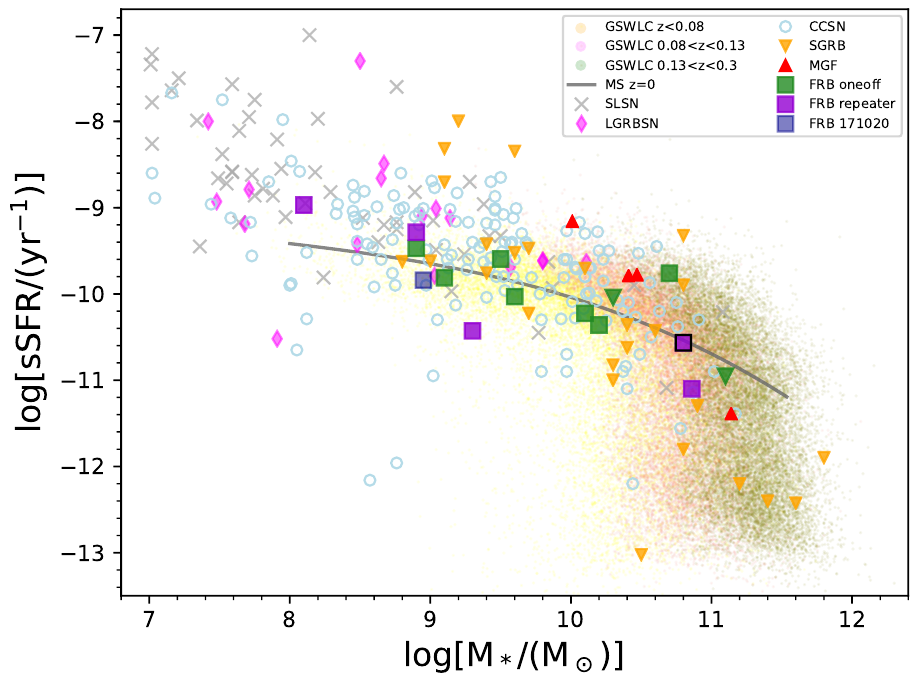
Figure 2. Specific SFR (SFR/M ∗ ) plotted against stellar mass for the FRB hosts and the galaxy pop- ulations of other transients. SFR and stellar mass values to derive the specific SFR are from [37,38] (FRB 20180916B), [93] (FRB 20200120), [78] (FRB 20180924B), [79] (FRB 20190523A). For the two latter FRBs the reported SFR values mark the upper limits (UL). The FRB hosts are indicated by filled squares (green for the one-off, purple for the repeaters) and filled green triangles for the two UL values. The associated errors are smaller than the size of the symbols. The two hosts with the highest masses among the repeaters are the Milky Way, hosting FRB 20200428A/SGR J1935+2154 (framed purple square), and M 81, likely hosting FRB 20200120E, respectively. We also added FRB 20171020A among the hosts of the one-off FRBs (blue square) which anyway still is a putative host. The galaxies in the GSWLC catalogue at three redshift ranges ( z < 0.08, 0.08 < z < 0.13 and 0.13 < z < 0.3, yellow, pink and dark-green light dots) have been used to represent normal field galaxies. The grey crosses are SLSNe-I hosts, the filled pink diamonds are LGRBs hosts [88]. Short GRB hosts [89,90], including the NGC 4993 galaxy (the host of GRB 170817A/GW 170817) [91], are shown as orange triangles. The red triangles represent the hosts of magnetar giant flares associated with short GRBs [28]. The dark-grey line follows the star formation MS at z = 0 (as parametrised in equation 5 by